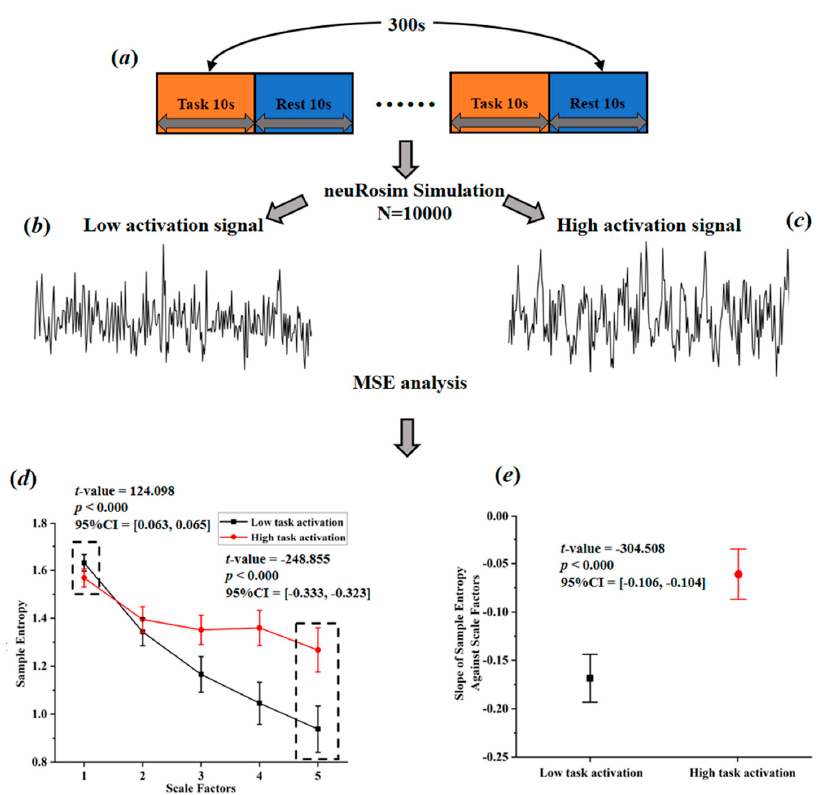
Figure 3. Simulated task-activated BOLD signals and multiscale entropy measures. ( a ) flow chart of stimulation task; ( b ) stimulated low activation signals; ( c ) simulated high activation signals; ( d ) entropy of the simulated signals over a range of scale factors; ( e ) the slopes of entropy measures against scale factors.